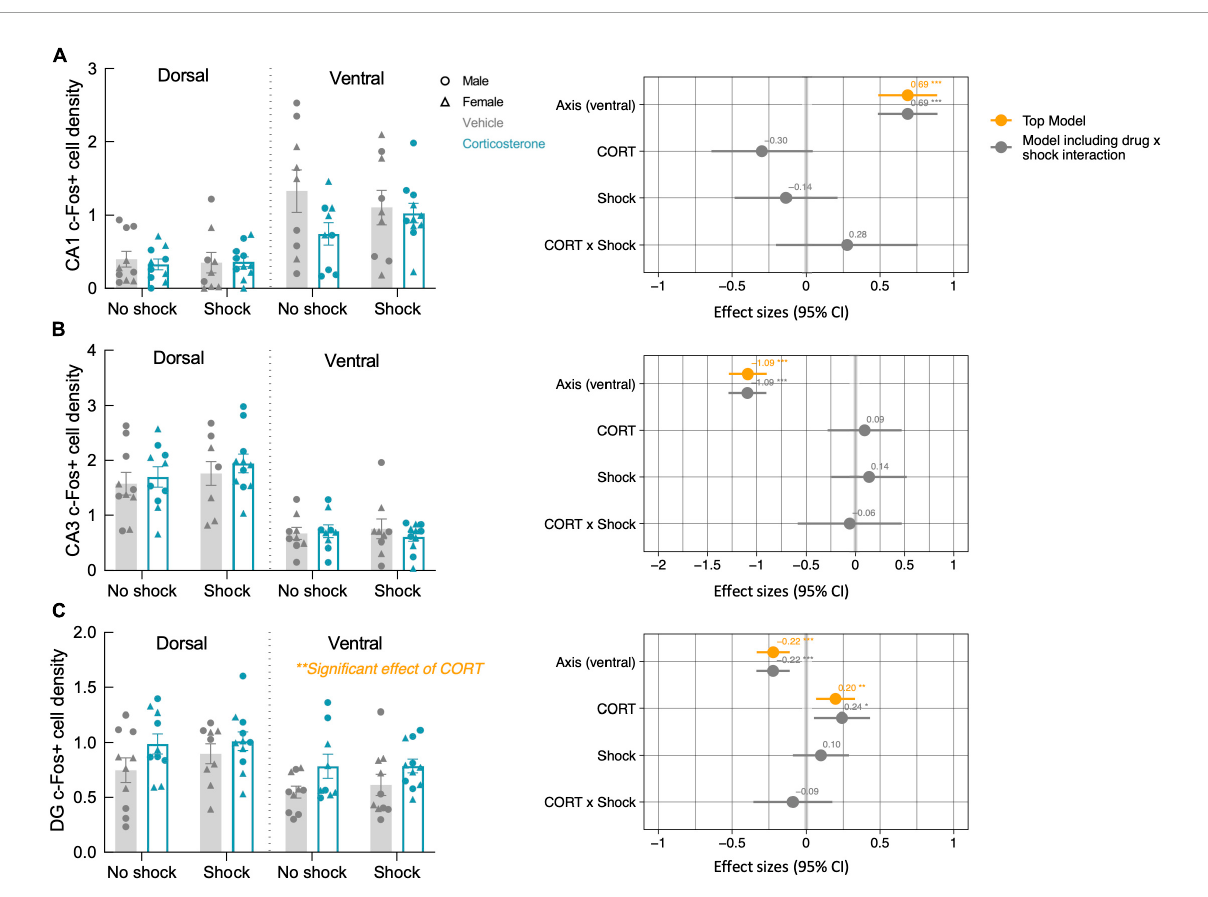
the corticosterone-treated mice. The top model for the dentate gyrus included corticosterone as a predictor and the effect size was significant ( Table 1 ). In all hippocampal regions, there was no interaction between the effect of corticosterone treatment and the effect of history of footshock on neural activity; the models that included an interaction between corticosterone treatment and shock fit the data poorly and the effect size of the interaction term was not significant ( Table 1